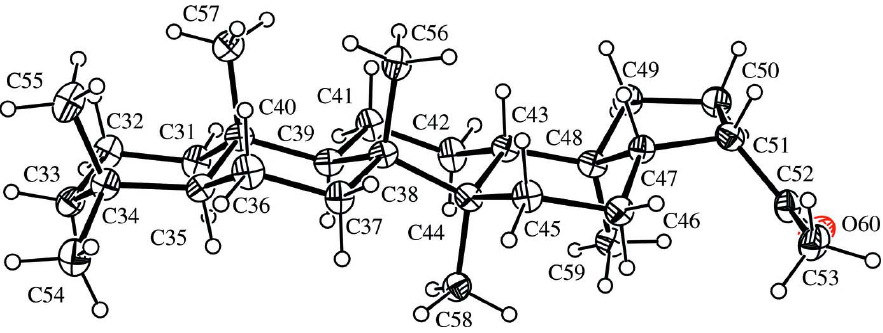
Figure 1 ORTEPII (Johnson, 1976) drawing of molecule A with displacement ellipsoids plotted at the 30% probability level.